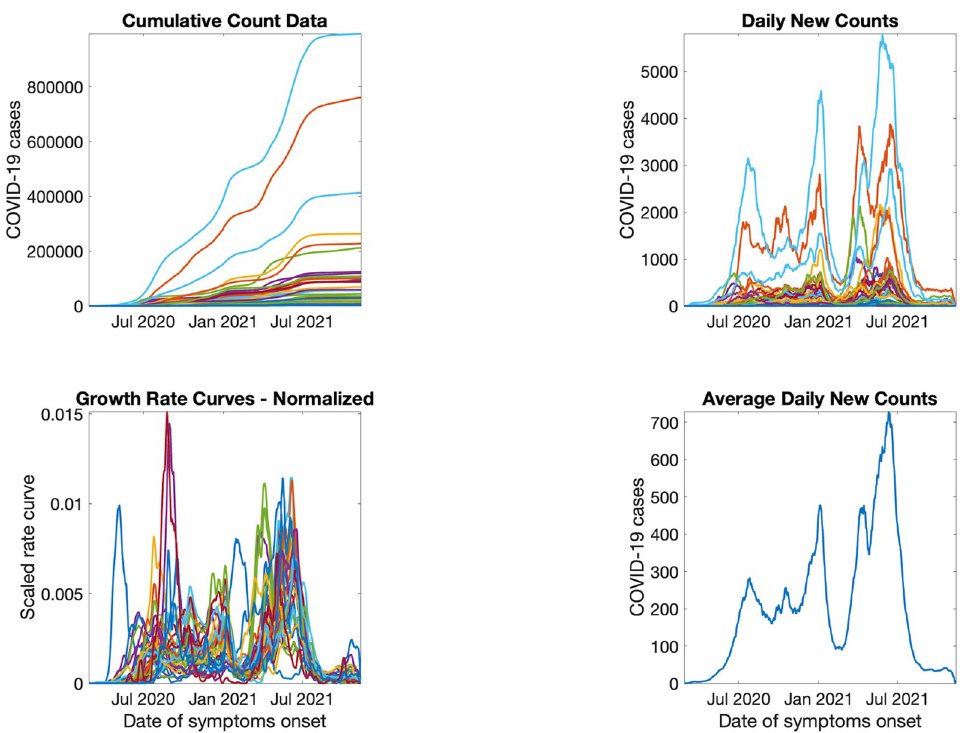
Fig 10. Pre-processing COVID-19 data into incidence rate functions. From left to right: the original lab-confirmed COVID-19 cases, curve of daily new cases, smoothed and scaled rate curves, and average of rate curves before scaling and